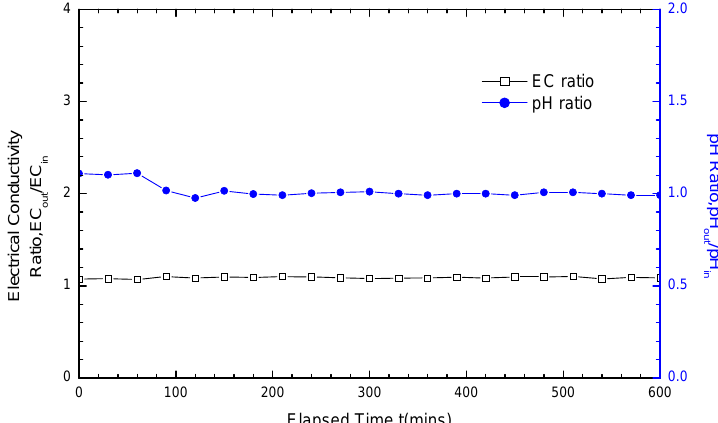
Figure 12. pH ratio and EC (electrical conductivity) ratio results for GCL specimens soaked solution for 20 days and permeated with the same solution after soaking. with 200 mM CaCl 2